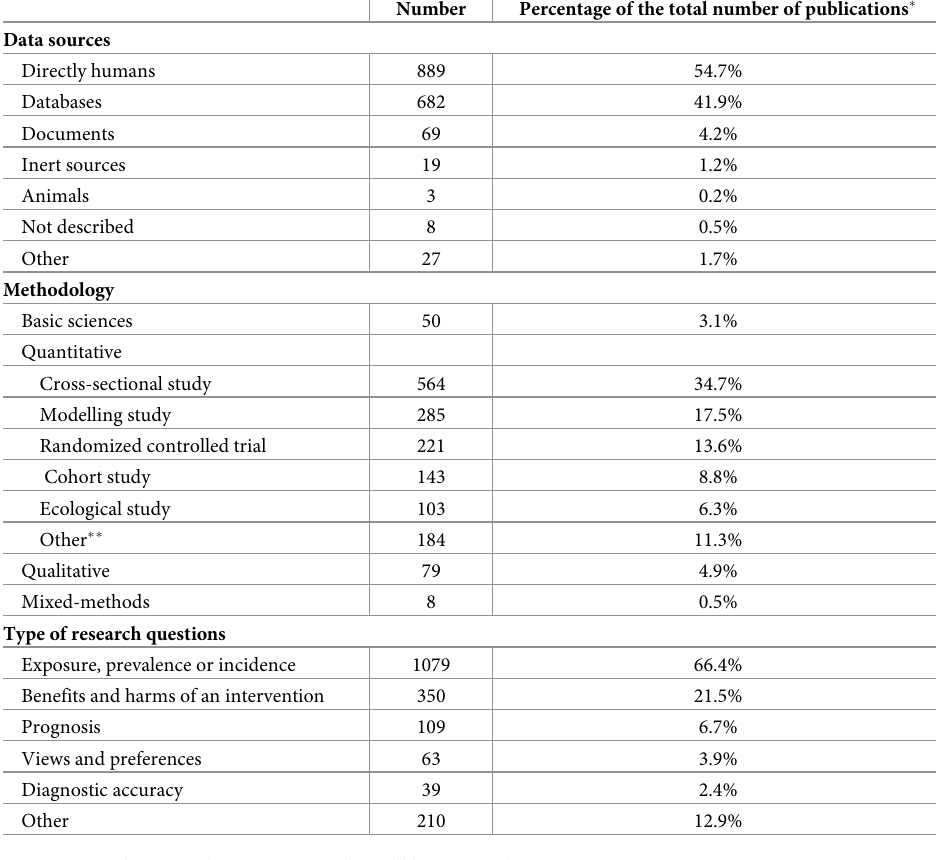
Table 2. Data sources, methods and research questions of empirical research related to COVID-19 in LAC